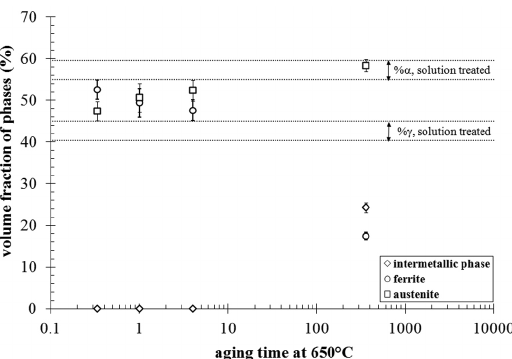
Figure 4. Volume fraction of phases as a function of aging time at 650°C.